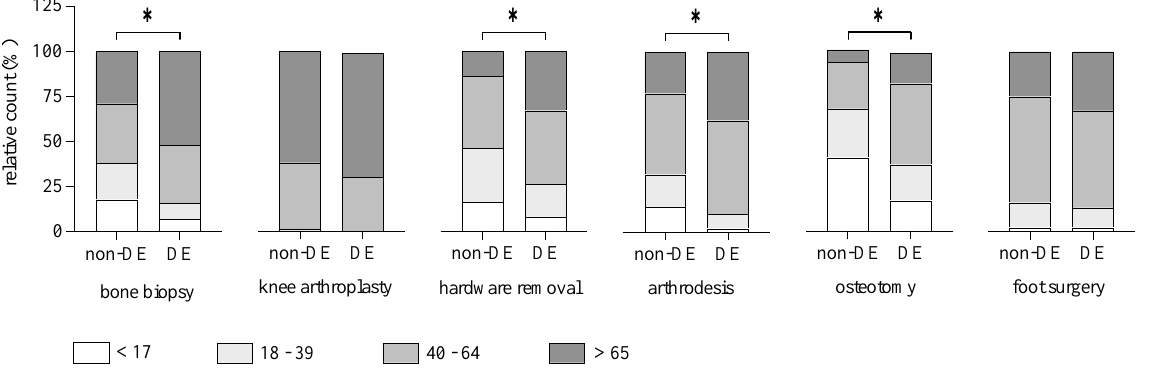
Figure 2. Relative count for orthopedic procedures per age group. The relative count for each surgical procedure (bone biopsy, knee arthroplasty, hardware removal, arthrodesis, osteotomy, and foot surgery) was expressed as a percentile fraction of the age subgroup (<17, 18 – 39, 40 – 64, or >65) divided by the sum of all subgroups. The absolute values can be found in Table 5. Pearson’s Chi - squared test (DE vs. non-DE; Chi-squared; * p < 0.01).